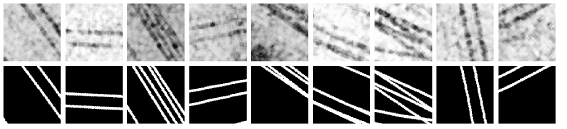
Figure 5. Exemplary training samples after data augmentation: a) translation, b) flipping, c) rotation, d) contrast, e) brightness.